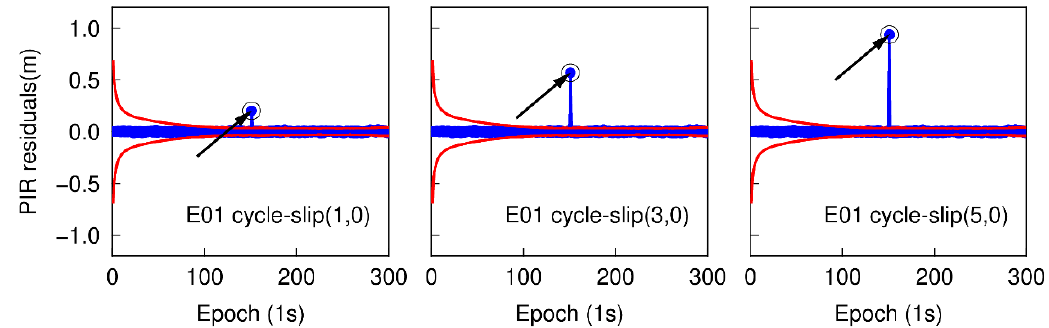
Figure 5. Small cycle-slip detection results using phase ionospheric residual (PIR) combination for G26.